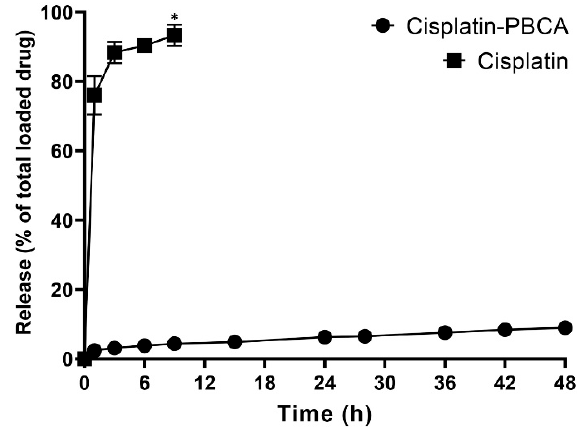
Figure 4. Release pattern of cisplatin from the standard cisplatin solution and PBCA nanoformulation. The results were expressed as the values ±5% from three independent experiments. Statistical analyses were performed using one-way ANOVA, F-test with * p < 0.05. The data were expressed as mean ± SD (n = 3).